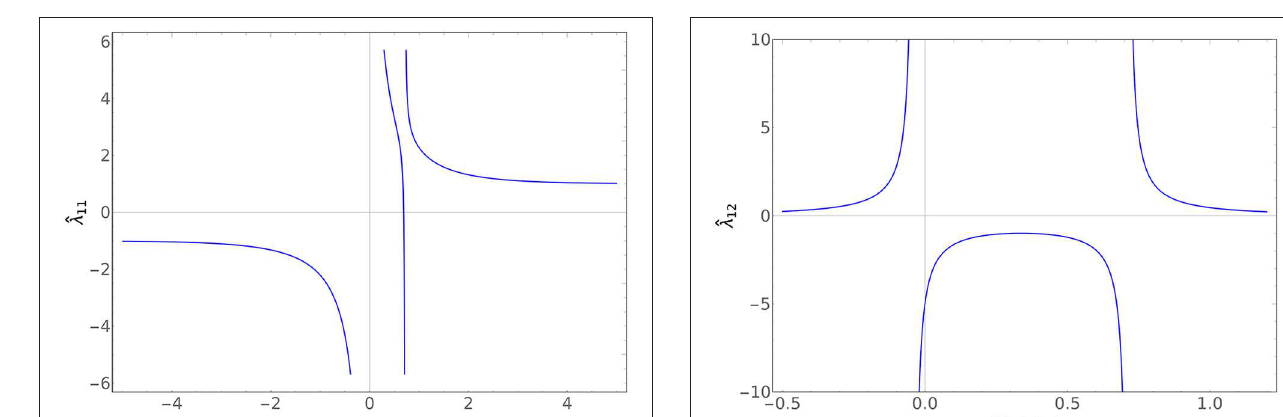
λ 12 vs ζ ln (ǫ/ǫ 1 ) for ζ 1 FIGURE 2 | Plot of ( ǫ 2 /ǫ 1 ) ζ 2 and ( ǫ 3 /ǫ 1 ) ζ = = b